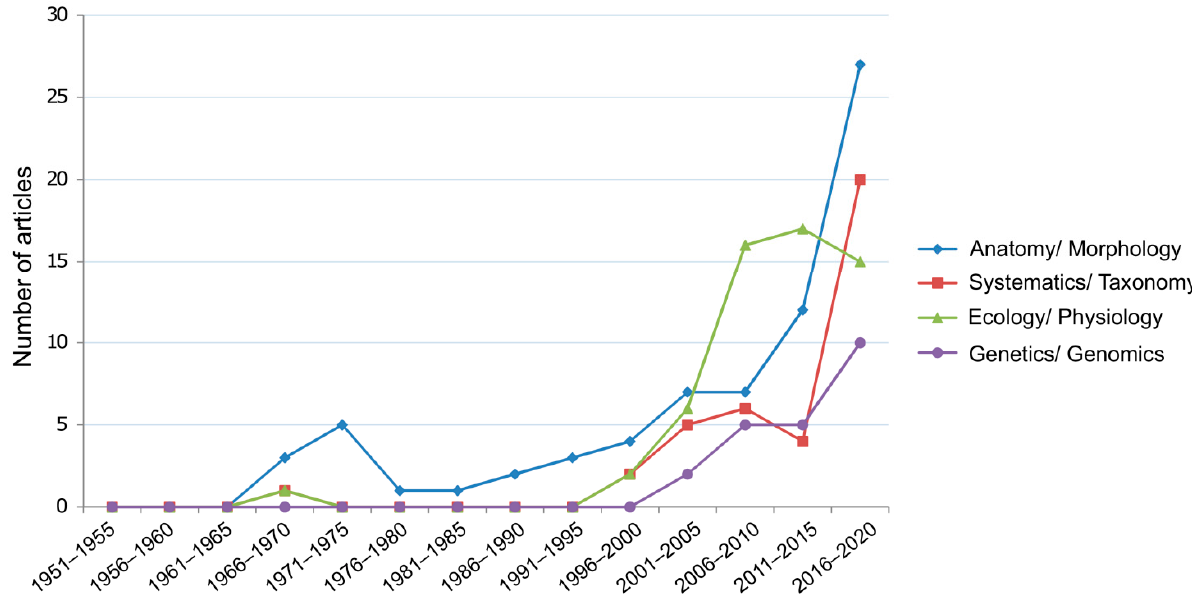
Figure 2. Number of scientific articles published between 1951 and 2020 referring to Utricularia and separated by research areas: anatomy and morphology, systematics and taxonomy, ecology and physiology, genetics and genomics. Each spot presents all articles published by each five years. The literature survey was conducted in the Web of Science (Clarivate Analytics) using the keywords: “(anatom * or morphology * or architecture * or structure *) and (utricularia or bladderwort*)” for the topic Anatomy/Morphology, “(systematic * or taxonom * or phylogeny * or cladistic *) and (utricularia or bladderwort*)” for Systematics/Taxonomy, “(ecology * or physiology * or ecophysiology *) and (utricularia or bladderwort *)” for Ecology/Physiology, and “(genetic * or genomic * or transcriptome * or proteome *) and (utricularia or bladderwort *)” for Genetics/Genomics. Following this non-exhaustive survey, all papers were manually inspected of their title, abstract, and keywords.